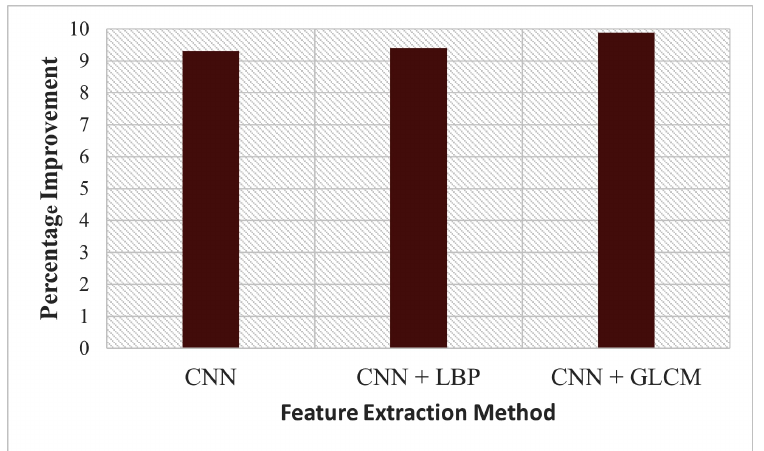
Figure 3. Percentage improvement over non use of images for the top three feature extraction methods; CNN, CNN + LBP, and CNN + GLCM.